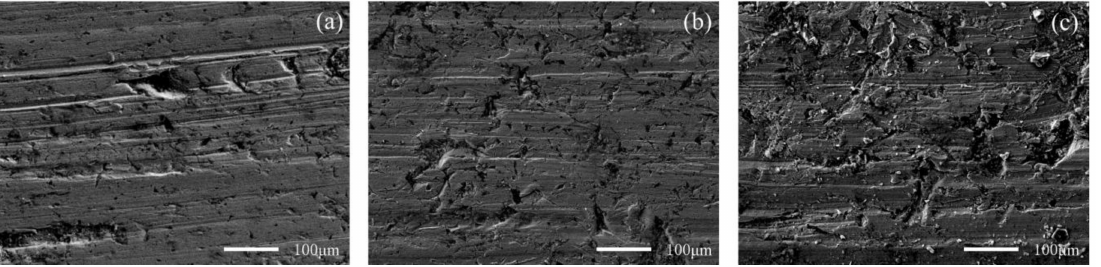
Figure 11. SEM morphology of worn surfaces of NM400 with varying percentage of coal gangue at acid simulated mine water: 30 wt% ( a ), 50 wt% ( b ), 70 wt% ( c